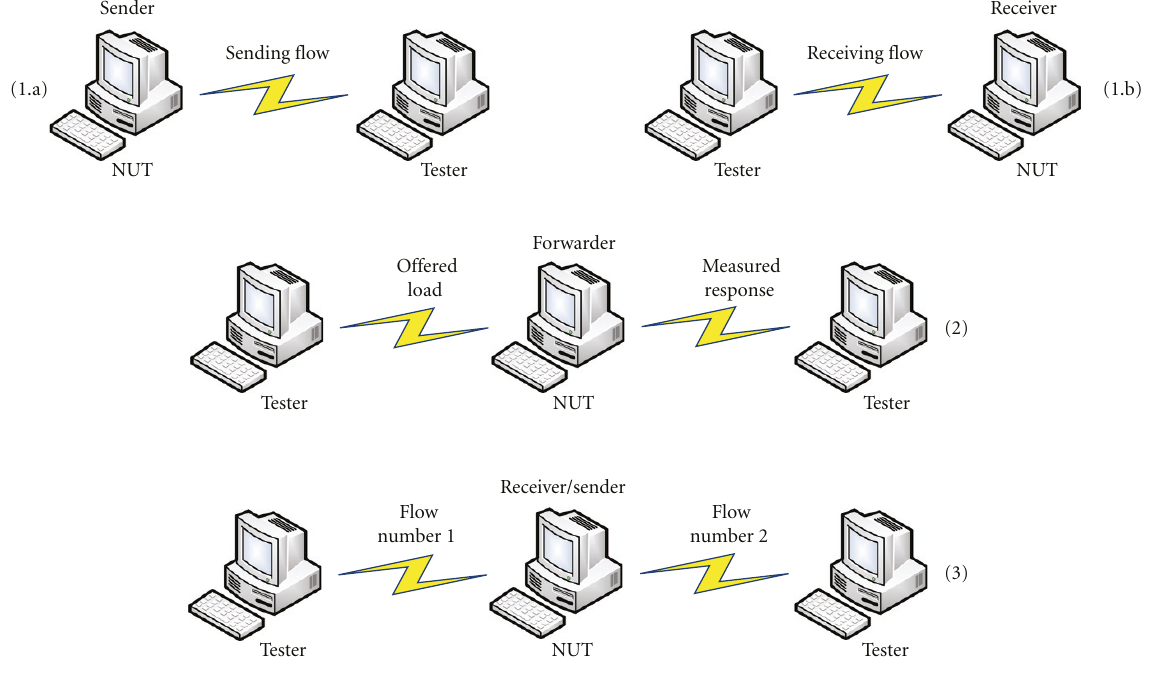
Figure 1: Experimental setup used to assess the tra ffi c generation (1.a) and reception (1.b) rates, the forwarding rates (2) , and the concurrence rates (3) of a wireless node under test